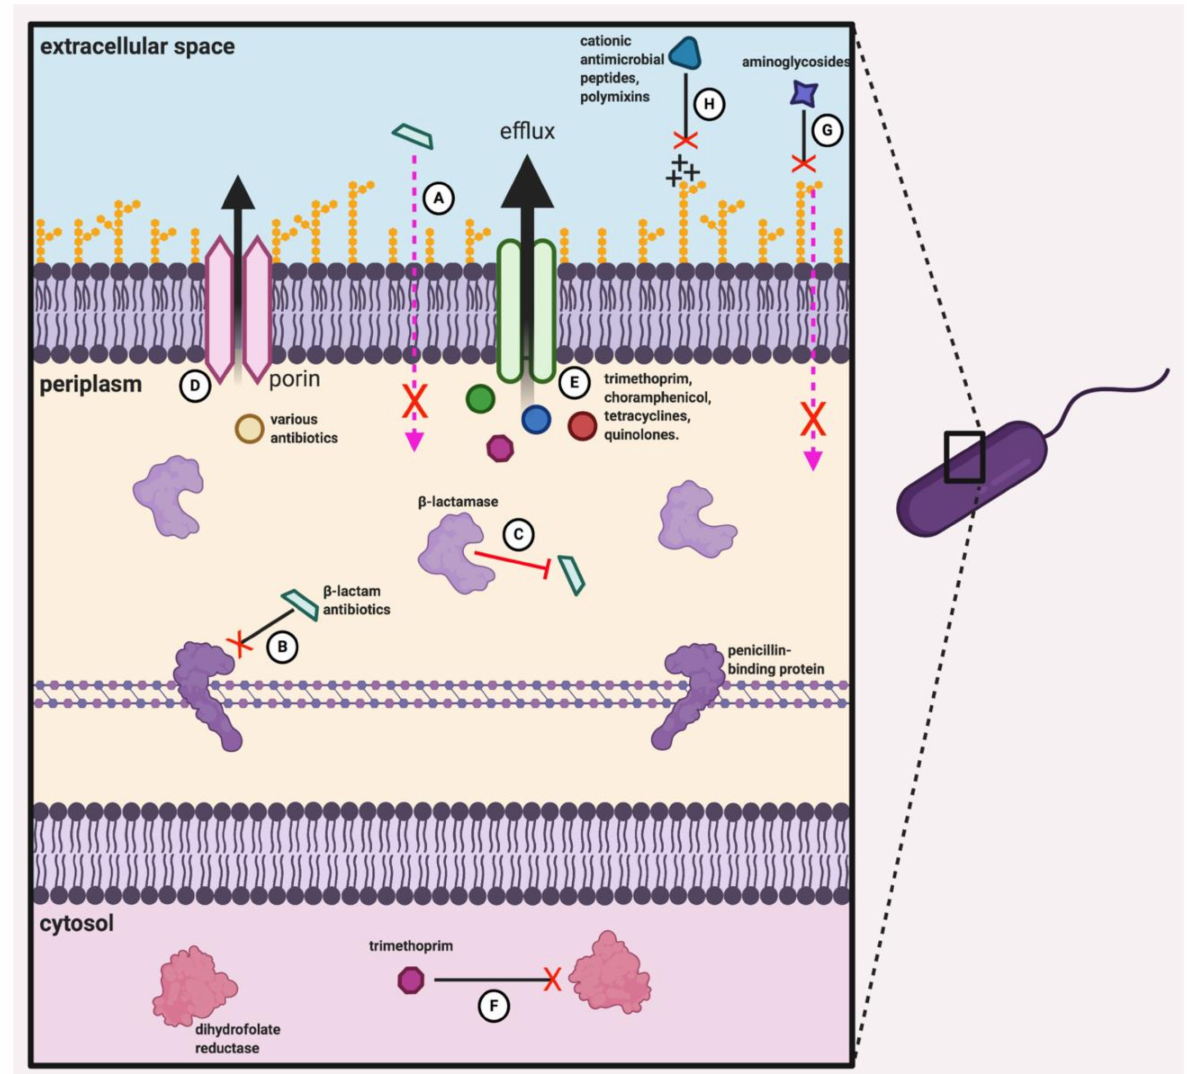
Figure 2. Antibiotic resistance mechanisms of the Burkholderia cepacia complex. Bcc members are resistant to a wide range of antibiotic compounds as a result of their large repertoire of both innate and acquired resistance mechanisms. Resistance to β -lactam antibiotics is achieved through a combination of reduced membrane permeability ( A ), mutated penicillin-binding proteins ( B ), and chromosomally encoded β -lactamases ( C ). Extrusion via porins ( D ) and efflux pumps ( E ) are responsible for resistance to a large number of compounds, including trimethoprim, chloramphenicol, tetracyclines and certain quinolones, while mutation of dihydrofolate reductase provides additional resistance to trimethoprim ( F ). At the outer membrane, LPS modifications prevent aminoglycoside binding and therefore block the trafficking of these compounds into the cell ( G ), while the reduced negative charge of the outer membrane reduces the binding of polymyxins and cationic antimicrobial peptides ( H ), thereby rendering Bcc species less vulnerable to these